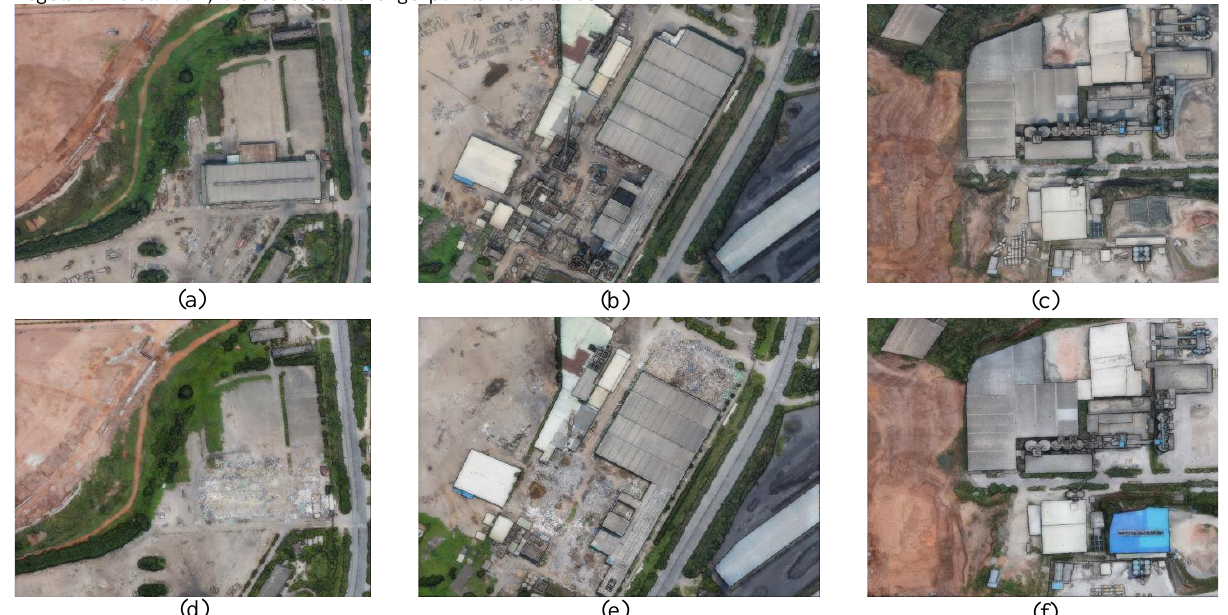
Figure. 3 Experimental data: (a) is the first phase point clouds of area 1, (d) is the second phase point clouds of area 1, (b) is the first phase point clouds of area 2, (e) is the second phase point clouds of area 2, (c) is the first phase point clouds of area 3, (f) is the second phase point clouds of area